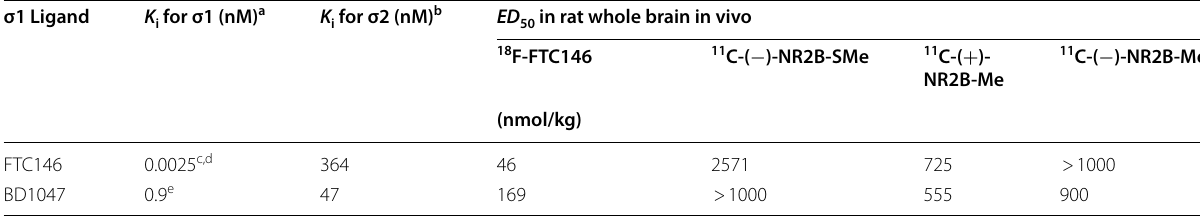
a Reference radioligand 3 H-pentazocine, except that 18 F-FTC146 was used for FTC146 b Reference radioligand 3 H-DTG c Ref.